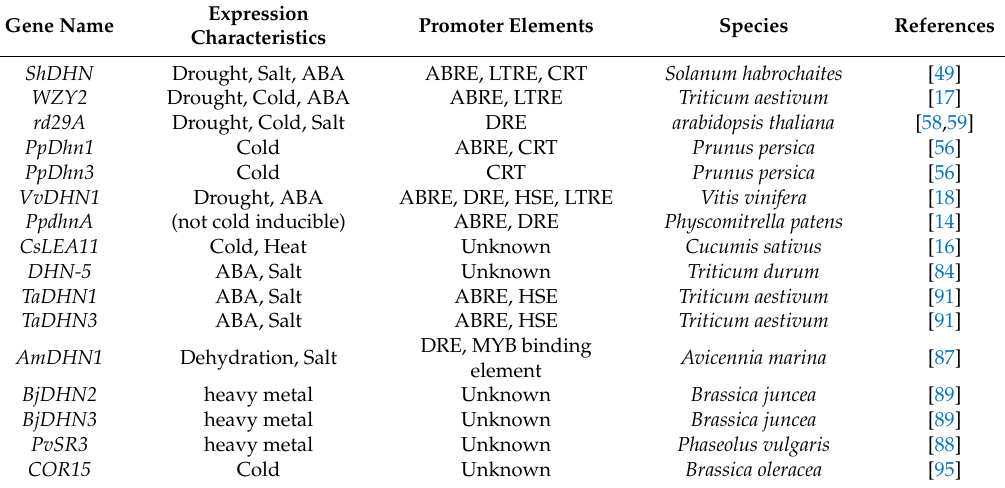
Table 1. An overview of dehydrins involved in abiotic stress